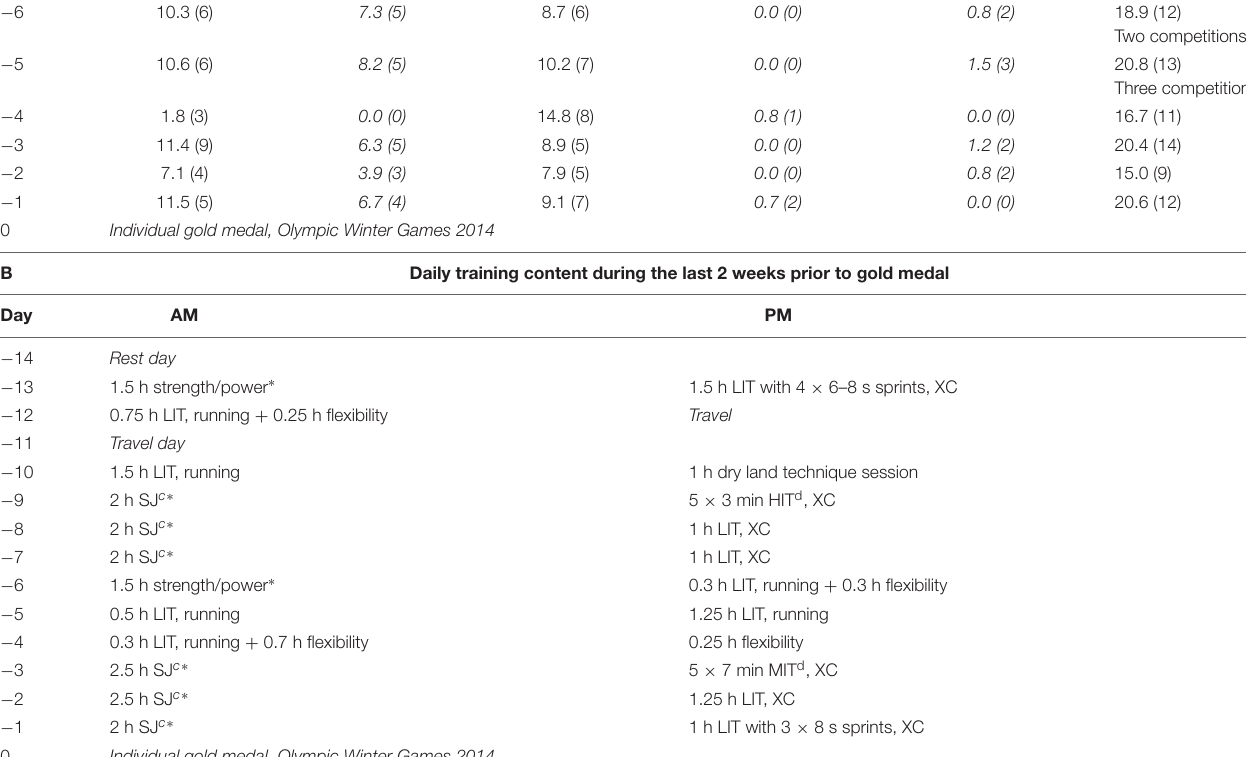
Individual gold medal, Olympic Winter Games